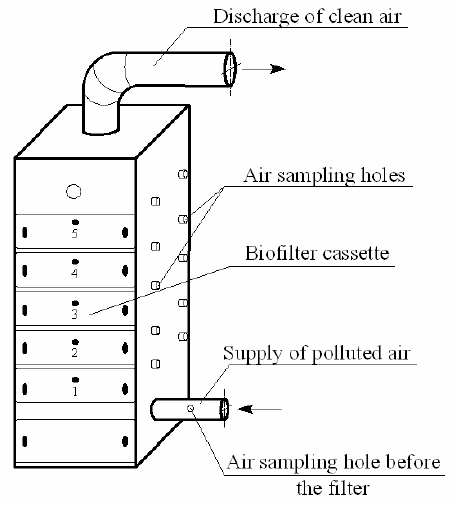
Fig 1. Stand of the laboratory biofilter